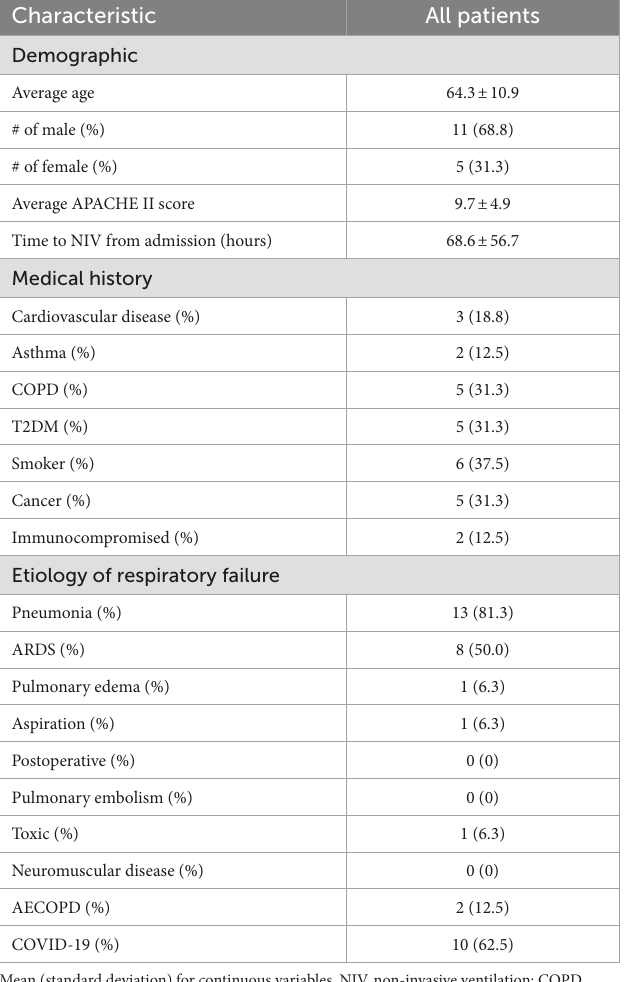
TABLE 1 Baseline demographics of included patients. Characteristic All patients